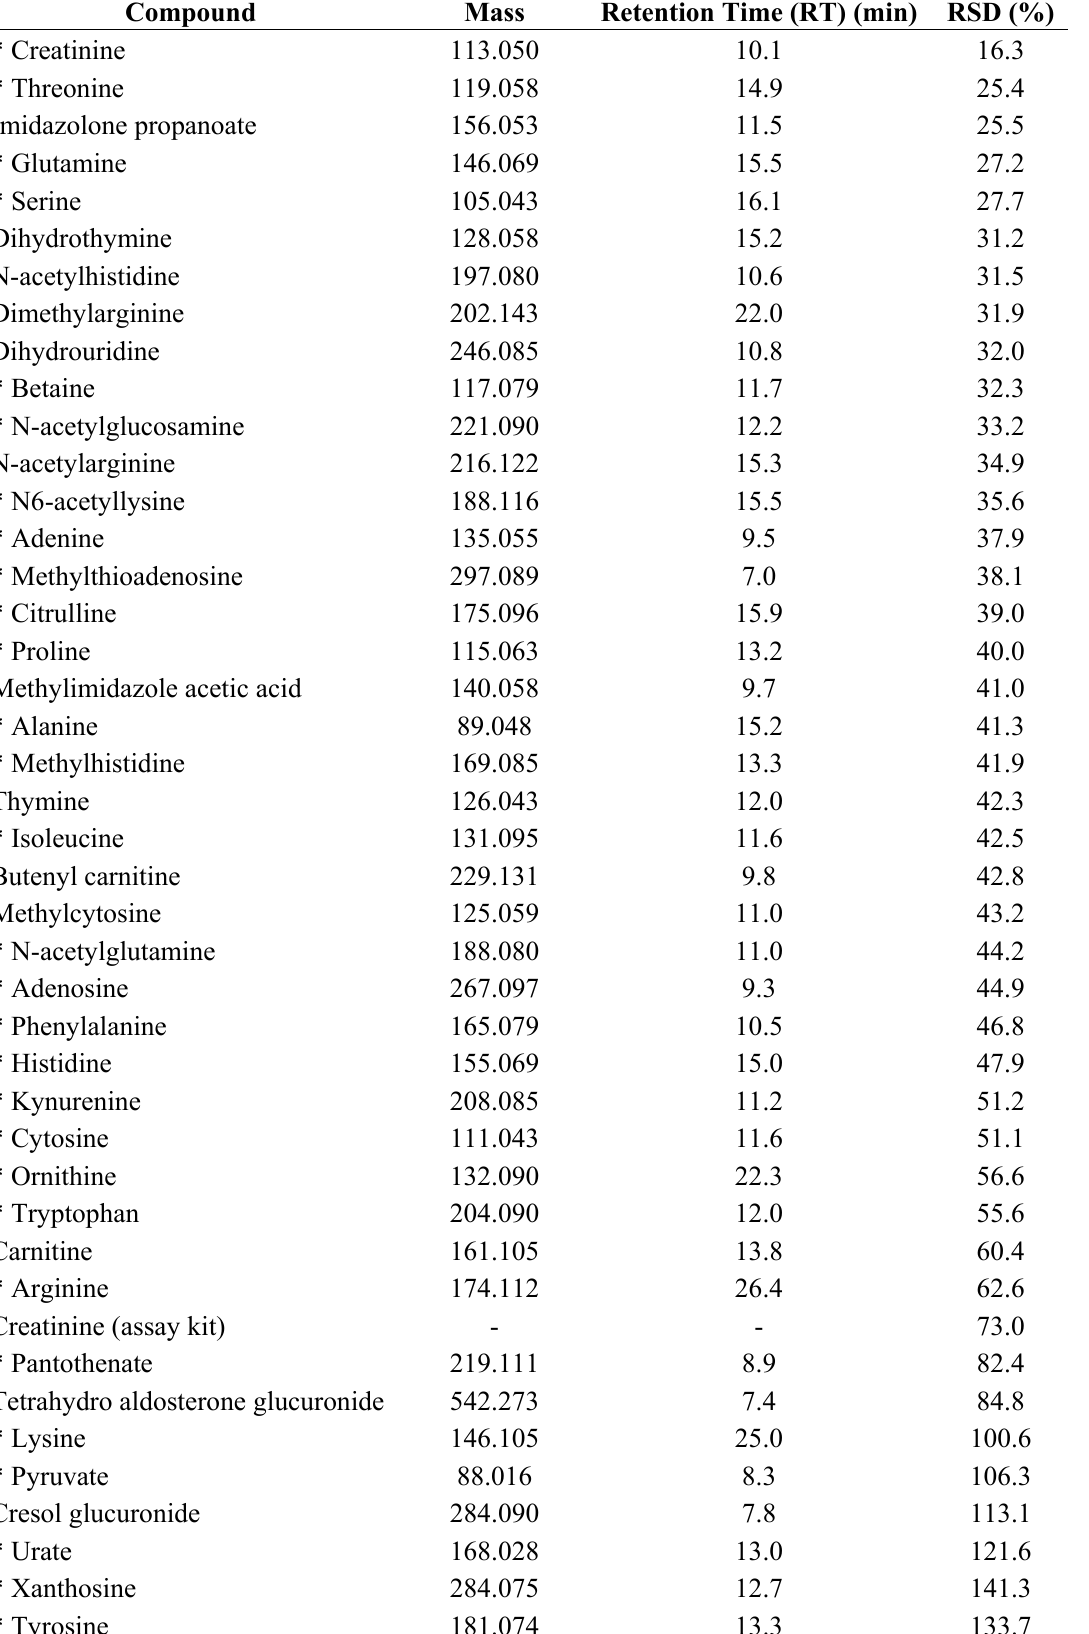
Table 1. RSD values for metabolites across 30 urine samples collected over 37 hours.